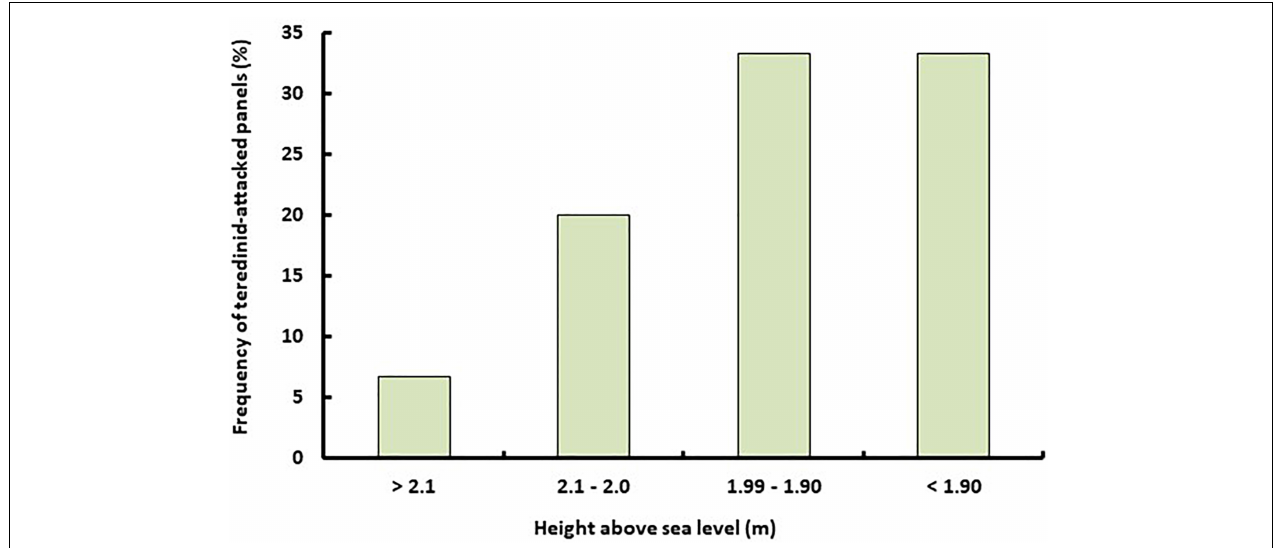
FIGURE 6 | Teredinid biodegrading activity increases as emersion time decreases. The frequency of teredinid-attacked experimental wooden panels ( n = 15) placed in areas of different elevations in Galua forest, Kaledupa Island,